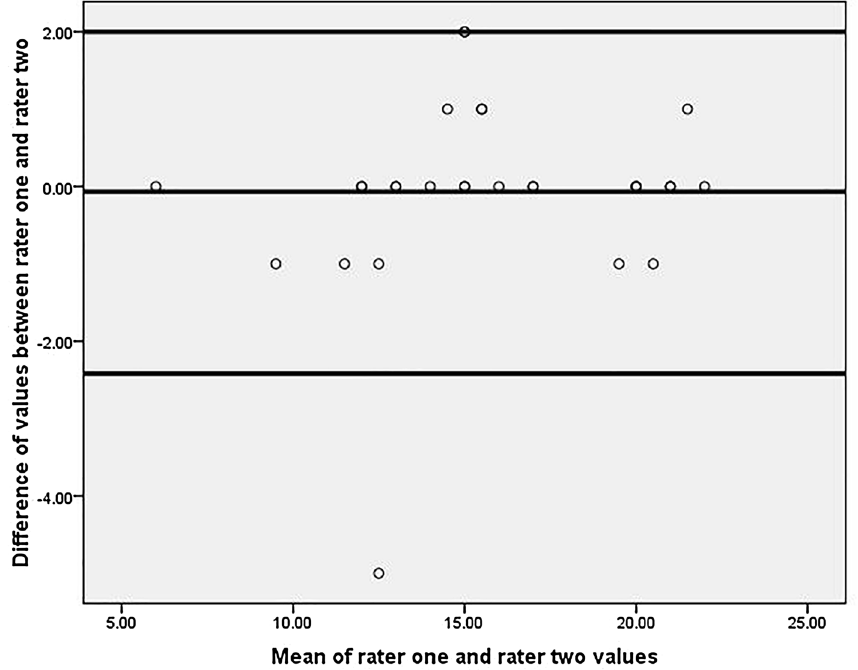
Figure 1. Bland Altman Graph representing inter-rater reliability. The horizontal middle dark line represents the mean, and the upper and lower dark line represents higher and lower standard deviations.